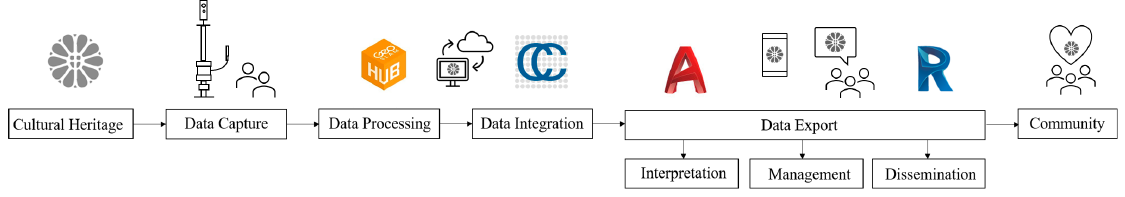
Figure 1: Flowchart of the complete workflow for the contribution to the Cisterscapes Garden